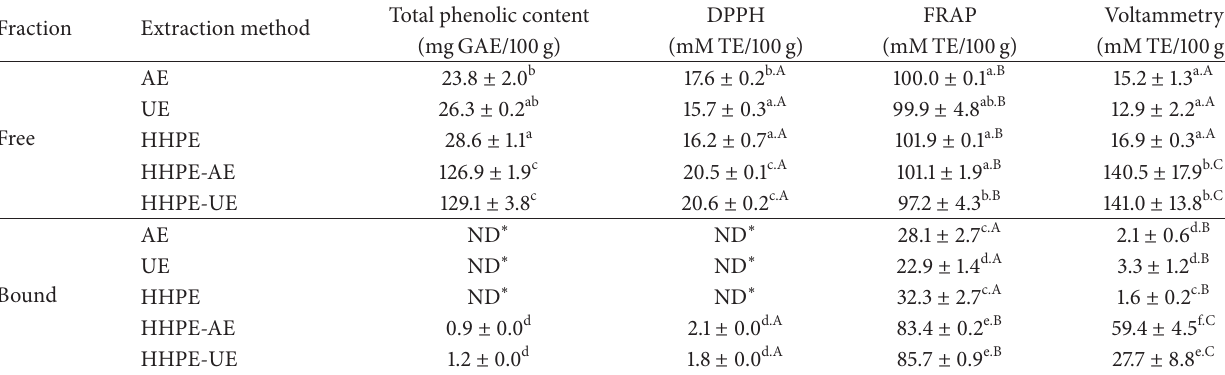
Table 2: Comparison among antioxidant capacity assays and extraction methods from Chilean papaya.